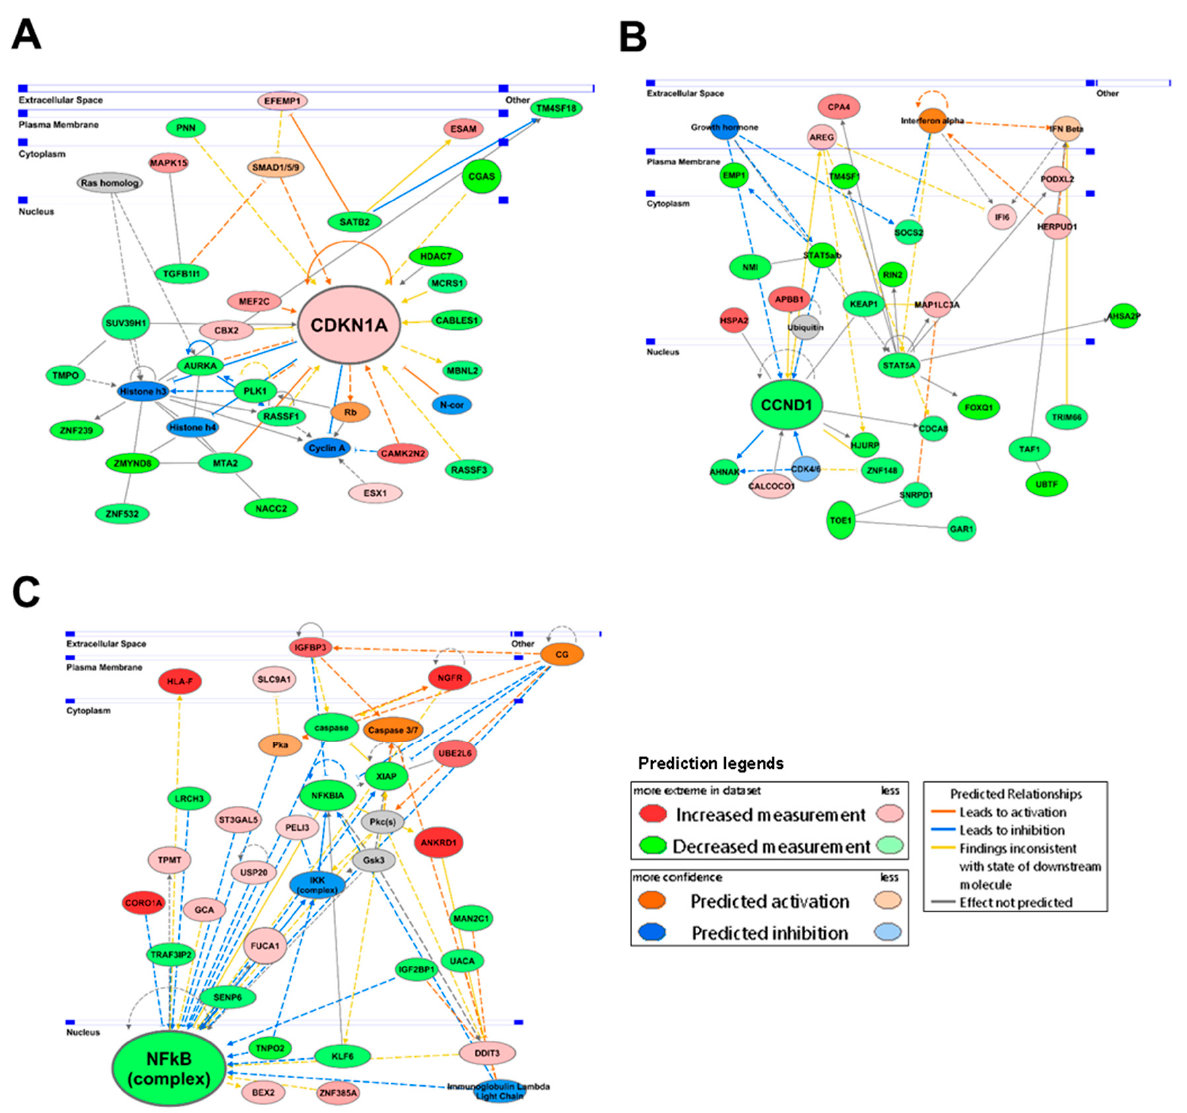
Figure 6. Top 3 IPA-determined networks in Panc-1 cells affected by 5 µM AS-10 at 12 h. ( A ) Network 1 displaying interactions among genes related to cell cycle, growth, and proliferation. ( B ) Network 2 displaying interactions among genes related to embryonic and organ development. ( C ) Network 3 displaying interactions among genes related to cancer, cell death and survival, and organismal injury and abnormalities. Central node molecules (CDKN1A, CCND1, and NF- κ B) linking multiple interacting genes were enlarged. The network overlaid with IPA Molecule Activity Predictor displayed the prediction of molecular changes. Red genes were significantly upregulated; green genes were downregulated; grey genes were not significantly changed. The colors of the predicted molecular changes are based on the activation Z-scores, with activation in orange and inhibition in blue.